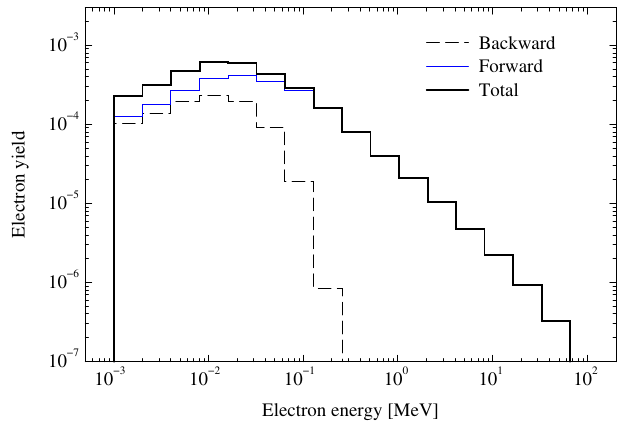
FIG. 8. Calculated energy distributions of secondary electrons that escape the carbon foil as thin as 600 (cid:3) g = cm 2 irradiated with an 8-GeV proton beam at normal incidence [10]. Normalization is per incident proton.